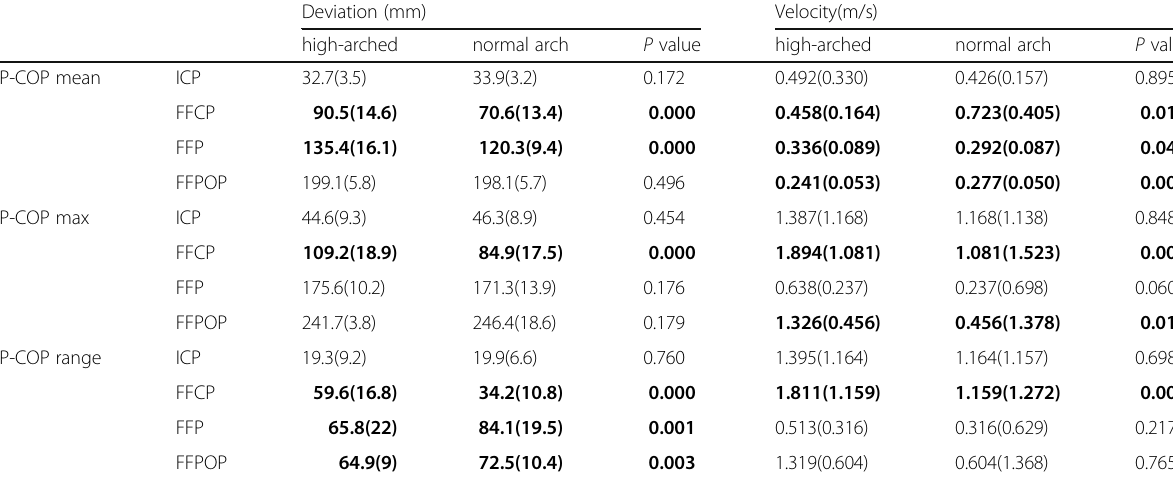
Table 3 Comparison of AP-COP deviation and velocity between high-archedes and normal